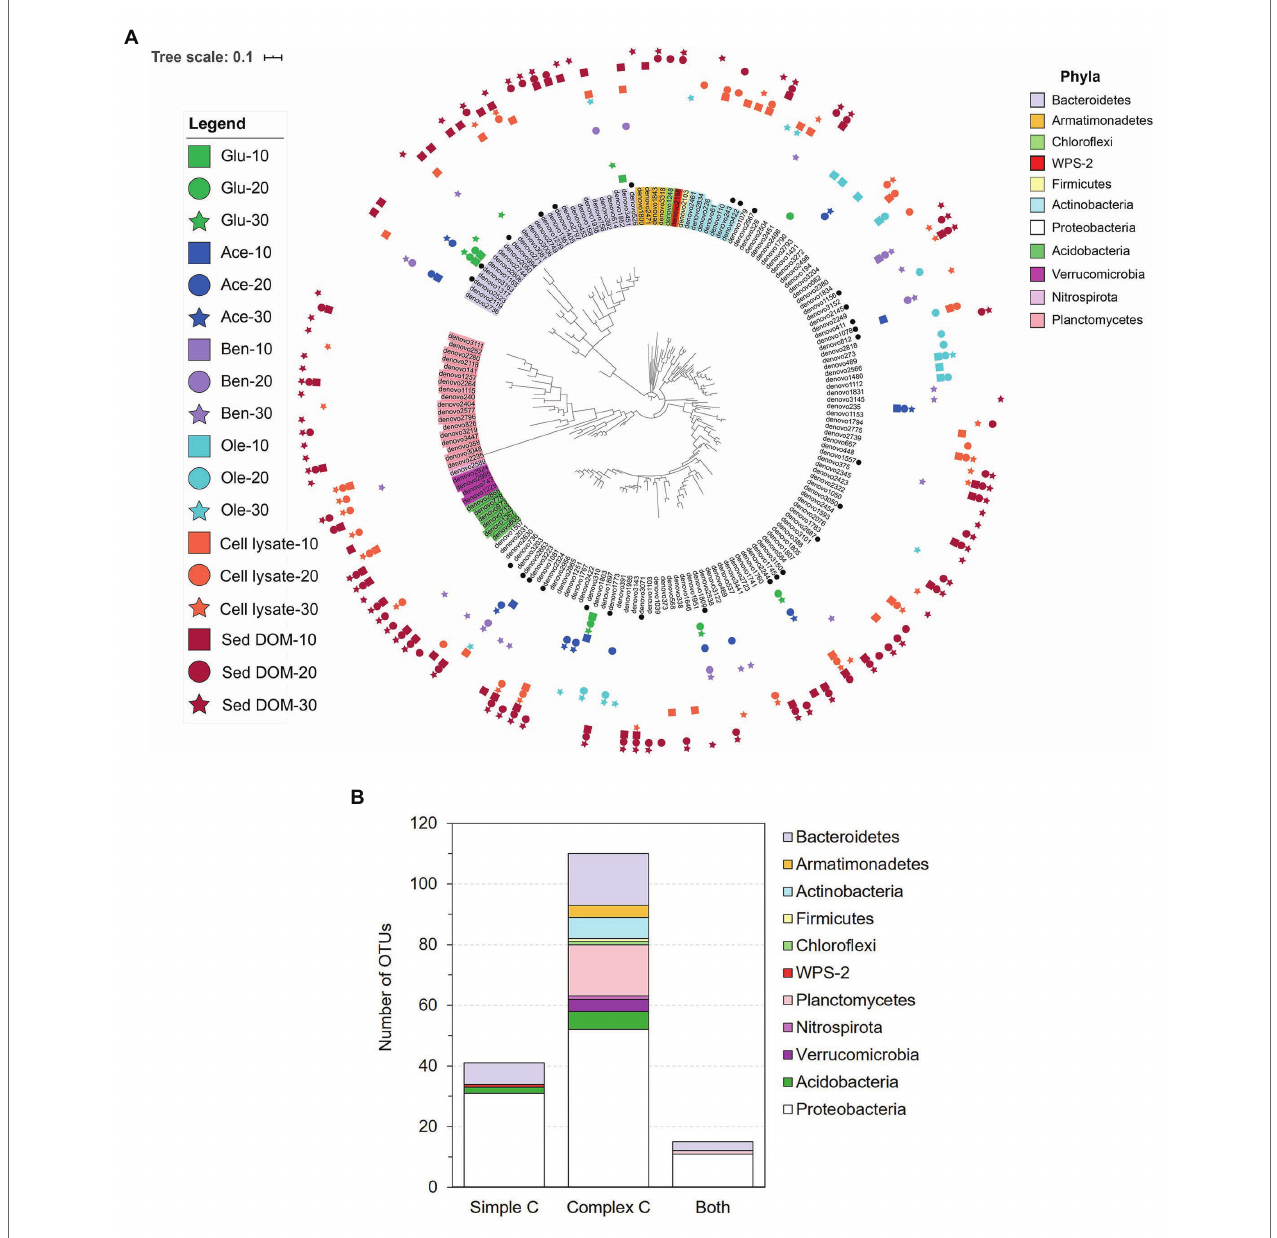
FIGURE 4 | Selected operational taxonomic units (OTUs; one-way ANOVA with Dunnett’s multiple comparison adjustment, p < 0.01) that were enriched by simple C (glucose, acetate, benzoate, or oleic acid) or complex C [bacterial cell lysate or sediment dissolved organic matter (DOM)] sources as compared to the unamended control. (A) Phylogenetic tree of the 166 enriched OTUs. OTU labels are highlighted according to their phyla. Black dots designate OTUs for which we obtained representative isolates (99–100% identity). Markers surrounding the tree denote the day (10 – square, 20 – circle, or 30 – star) and C substrate in which the OTU was significantly enriched. (B) The number of OTUs that were enriched exclusively by simple C, exclusively by complex C, and by both simple and complex